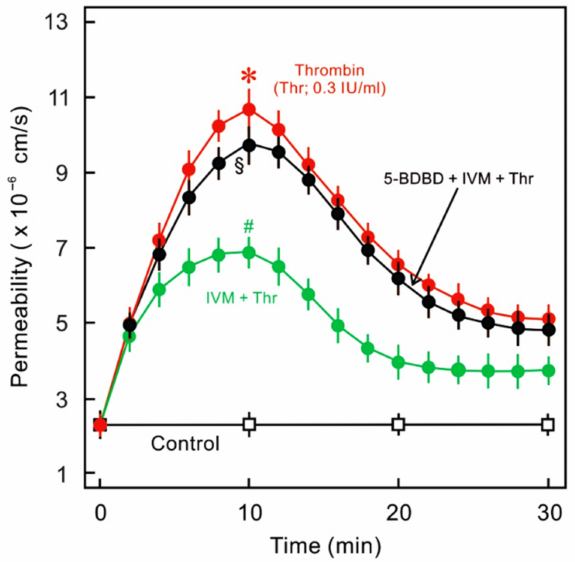
Figure 3. Effect of P2X4 receptor modulator (ivermectin; IVM) and antagonist ((5-(3-bromophenyl)- 1,3-dihydro-2H-benzofuro[3,2-e]-1,4-diazepin-2-one: 5-BDBD) on thrombin-induced endothelial hyperpermeability. HUVEC monolayers cultured on filter membranes were exposed to human thrombin (Thr, 0.3 IU/mL) in the absence (red) or presence (green) of ivermectin (IVM; 50 µ M) and the flux of labelled albumin was measured as described previously [84]. In a parallel set of experiments, P2X4 receptor antagonist (5-BDBD; 10 µ M) was added before the addition of ivermectin and thrombin. n = 4, * p < 0.05 vs. control, # p < 0.05 vs. Thr alone, § p < 0.05 vs. IVM + Thr. For experimental details, please see methods in Supplementary